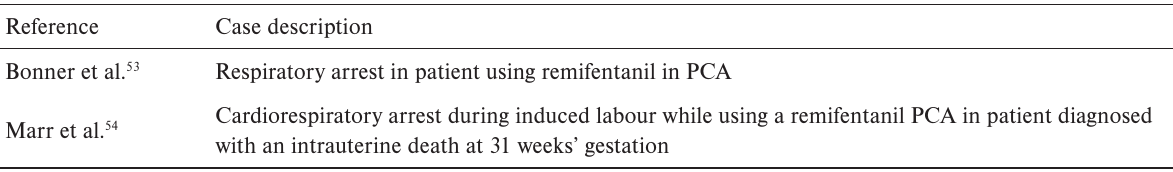
Table 5. Case reports of patients using patient controlled analgesia.